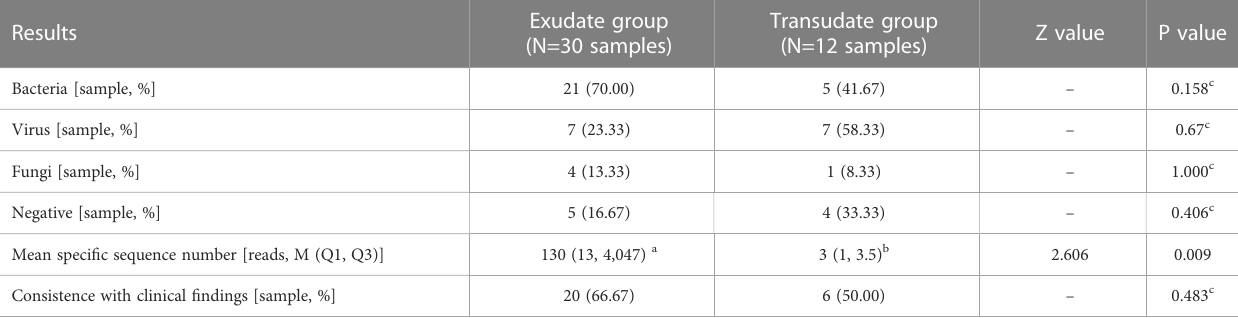
TABLE 3 Comparison of some observation indicators of pleural and peritoneal effusion exudate and transudate.